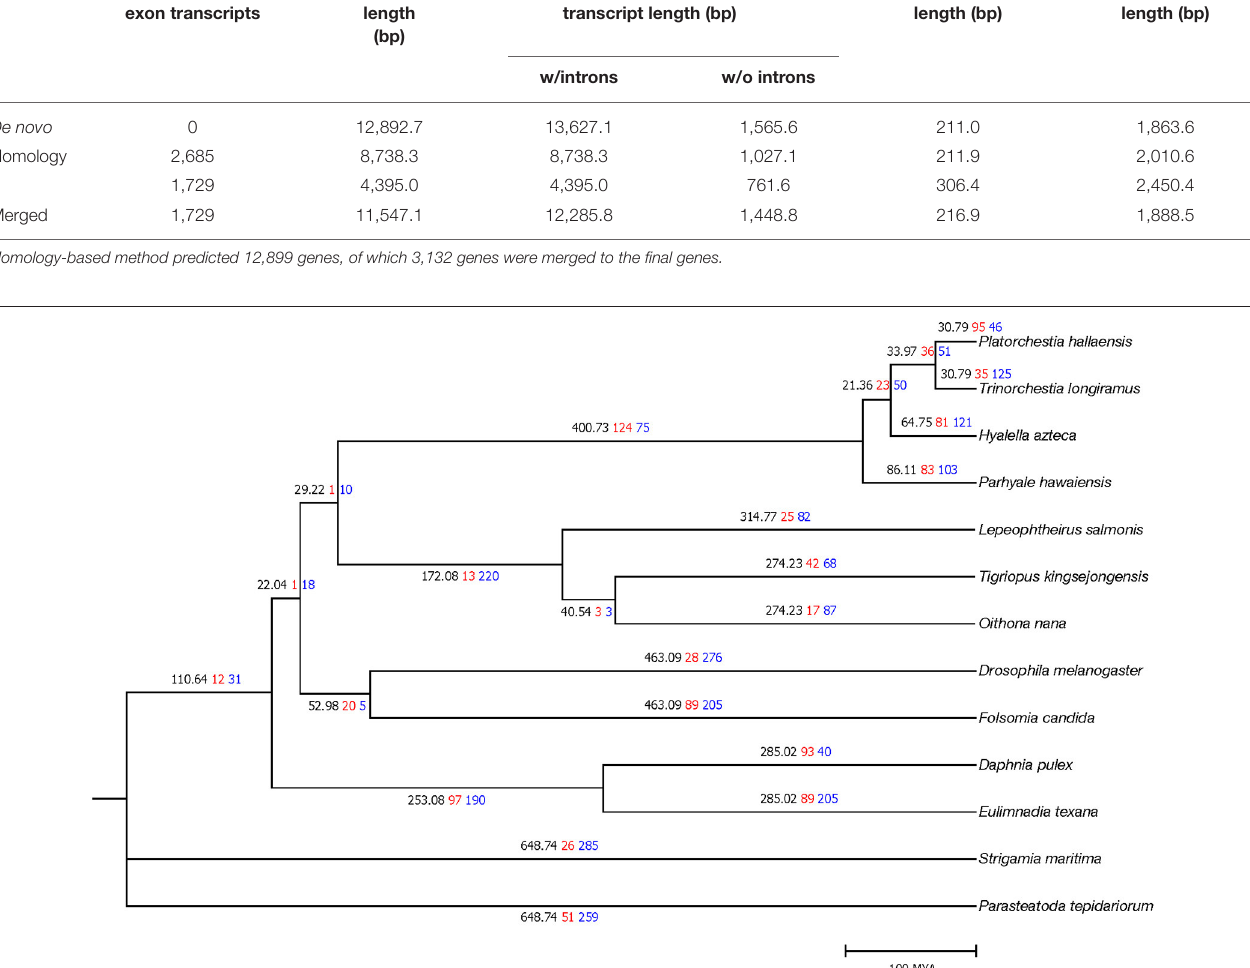
Frontiers in Genetics |